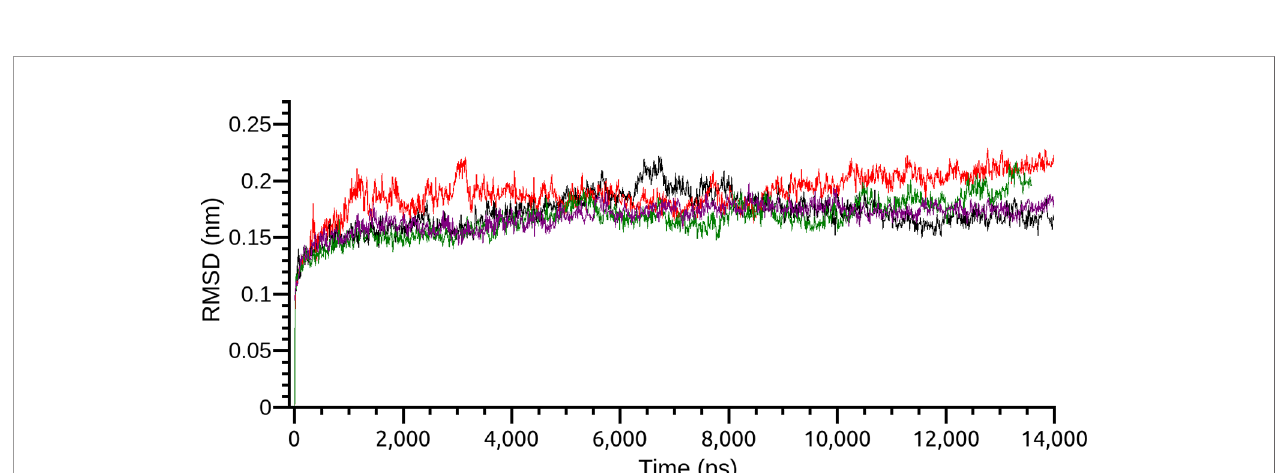
FIGURE 3 | Root-mean-square deviation (RMSD) of the two most interesting binding poses of compound 1 on PDE4A and PDE4B. Each pose is indicated by a different